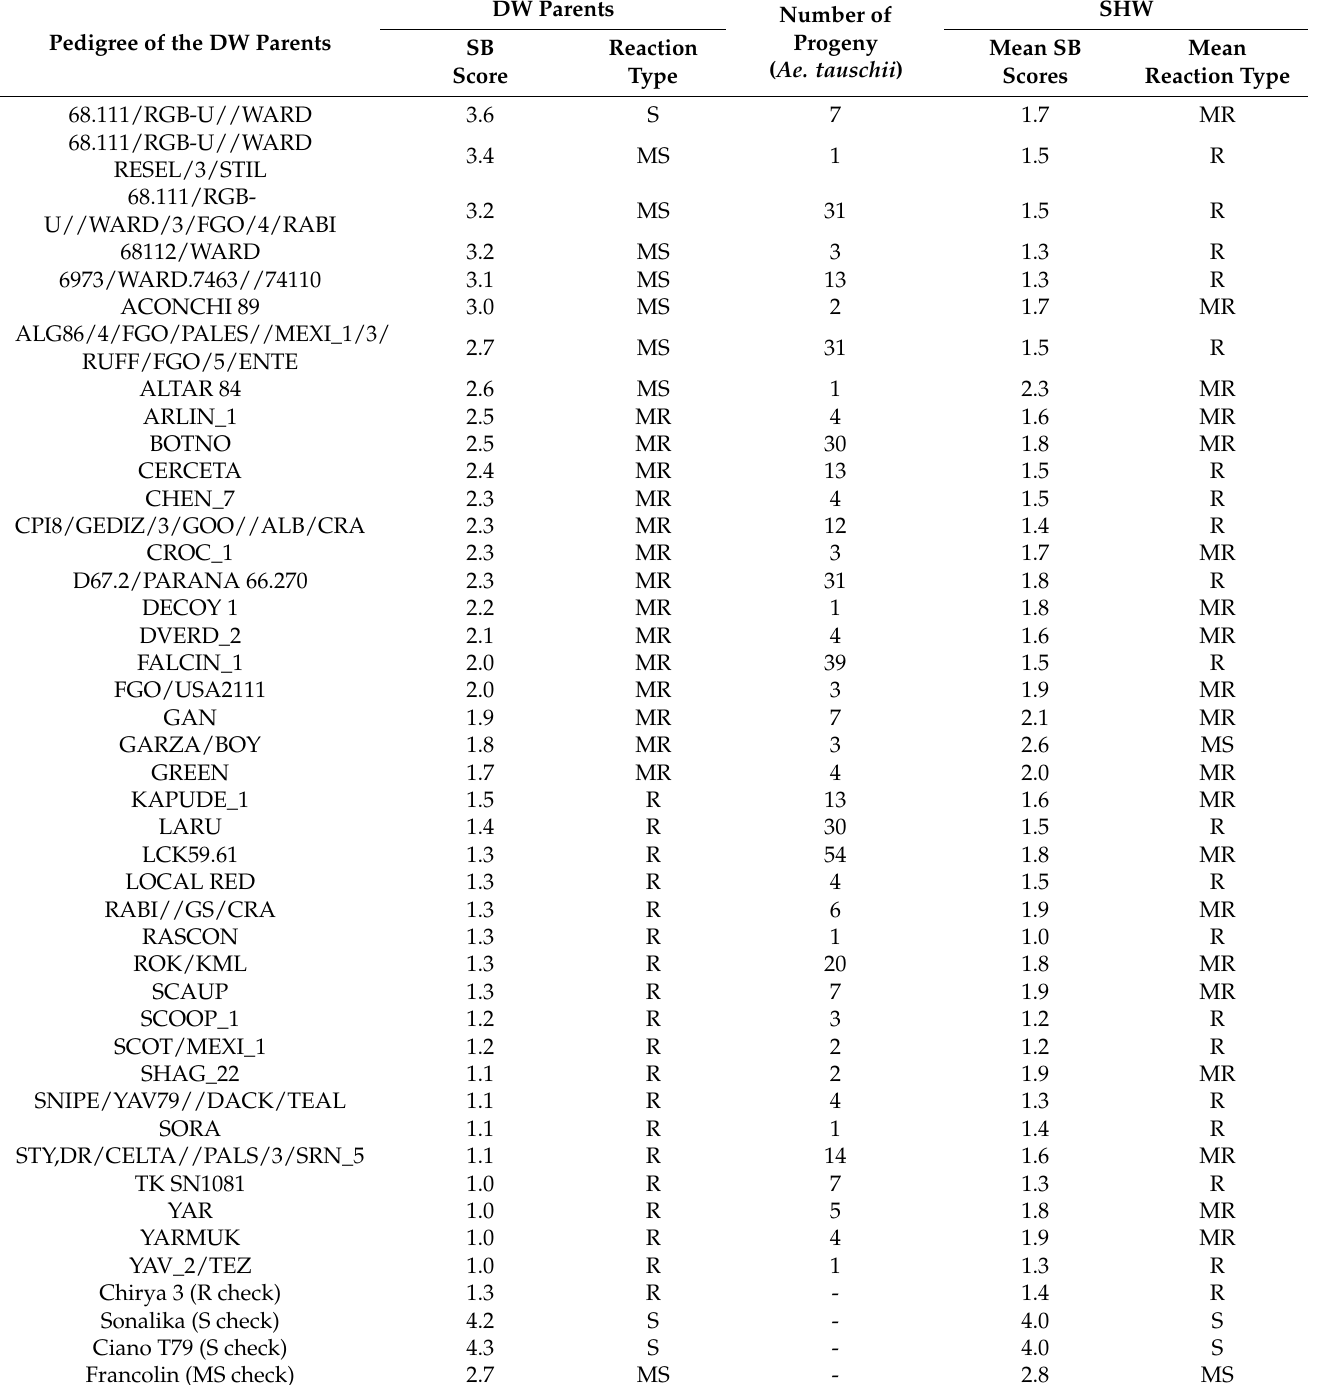
Table 1. Spot blotch (SB) reactions of 40 durum wheat (DW) parents, their respective synthetic hexaploid wheat (SHW) and four checks. Reactions are defined as Resistant (R, 1.0–1.5), Moderately Resistant (MR, 1.6–2.5), Moderately Susceptible (MS, 2.6–3.5), and Susceptible (S, 3.6–5.0). For 18 SHW lines, their DW parents were not